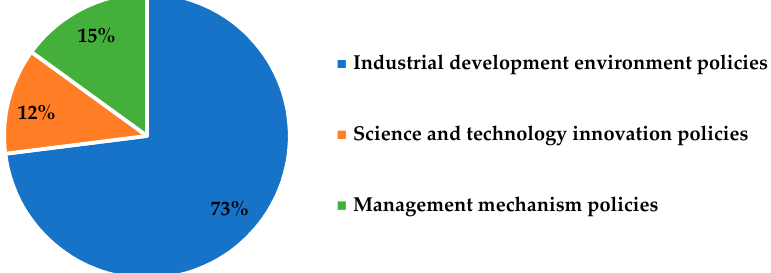
Figure 4. Types of existing policies in the green lighting industry. Data sources: [26].